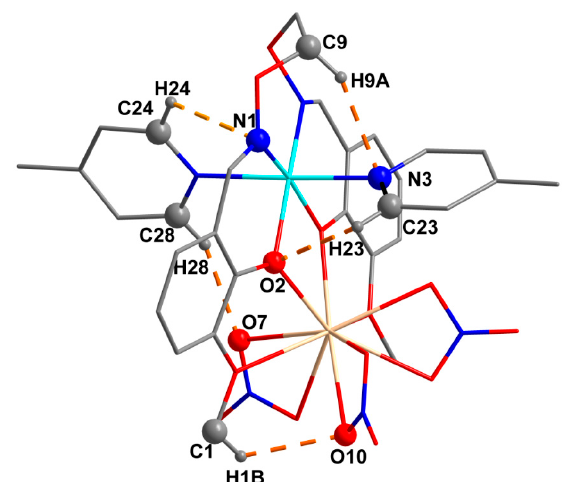
Figure 4. View of the intramolecular hydrogen bond interactions of the Ni(II)-Sm(III) polymer (hydrogen Figure4. ViewoftheintramolecularhydrogenbondinteractionsoftheNi(II)-Sm(III)polymer(hydrogen atoms are omitted for clarity, except those forming hydrogen bonding). atoms are omitted for clarity, except those forming hydrogen bonding). Table 3. Hydrogen bonding interactions (Å, ° ) and C-H··· π stacking interactions for the Ni(II)-Sm(III) polymer.